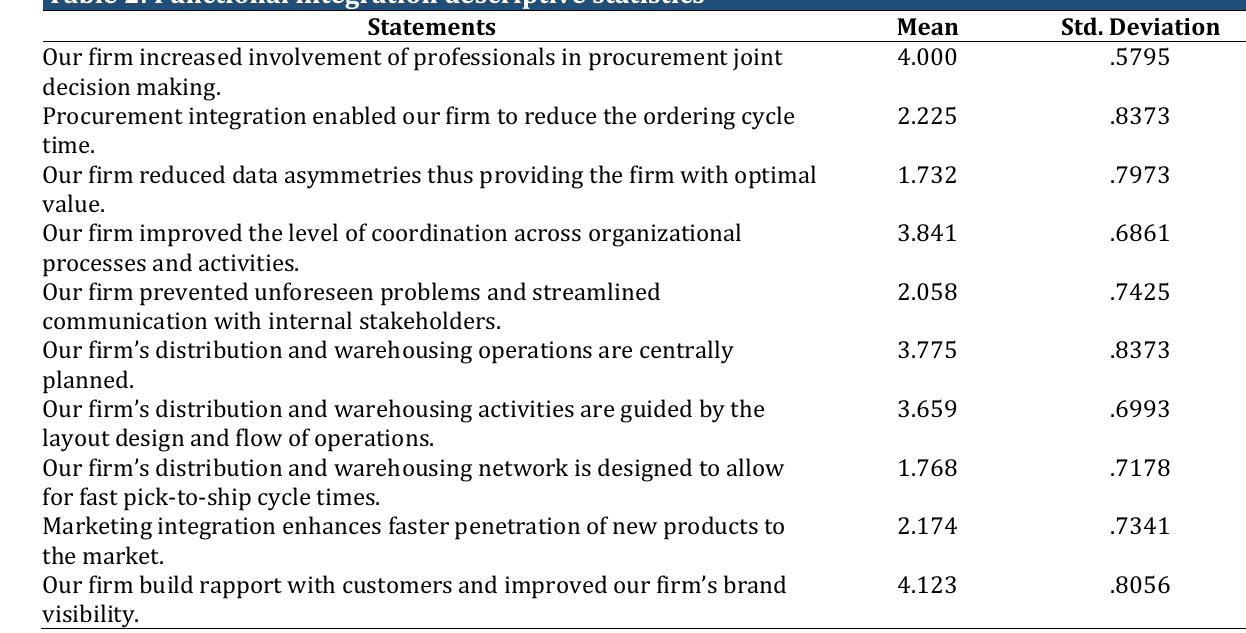
Table 2: Functional integration descriptive statistics